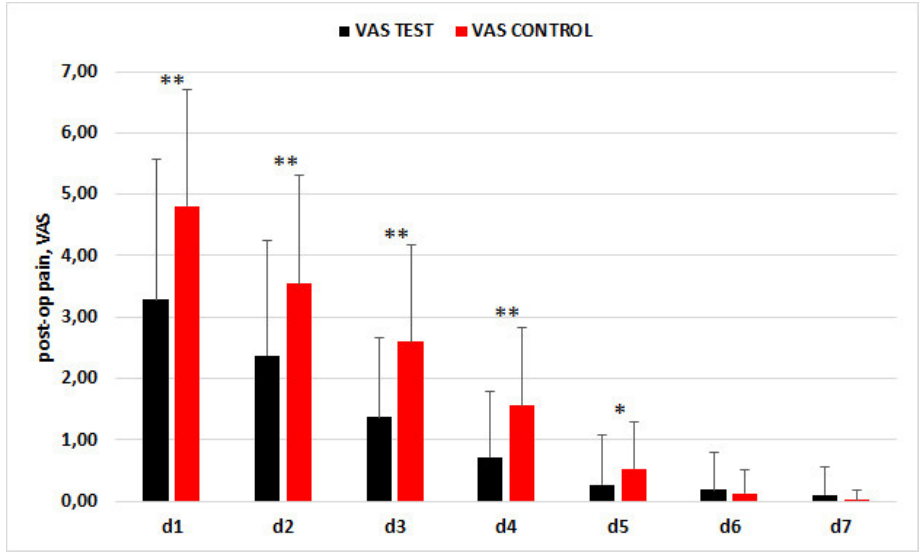
Figure 2. Trend of VAS scores in the two groups in the first week postextraction.* p < 0.05, ** p < 0.001. For alveolar socket dimensions (vestibulo-palatal/lingual, VP; mesio-distal, MD), none of the comparisons between groups at baseline showed significance. There was a